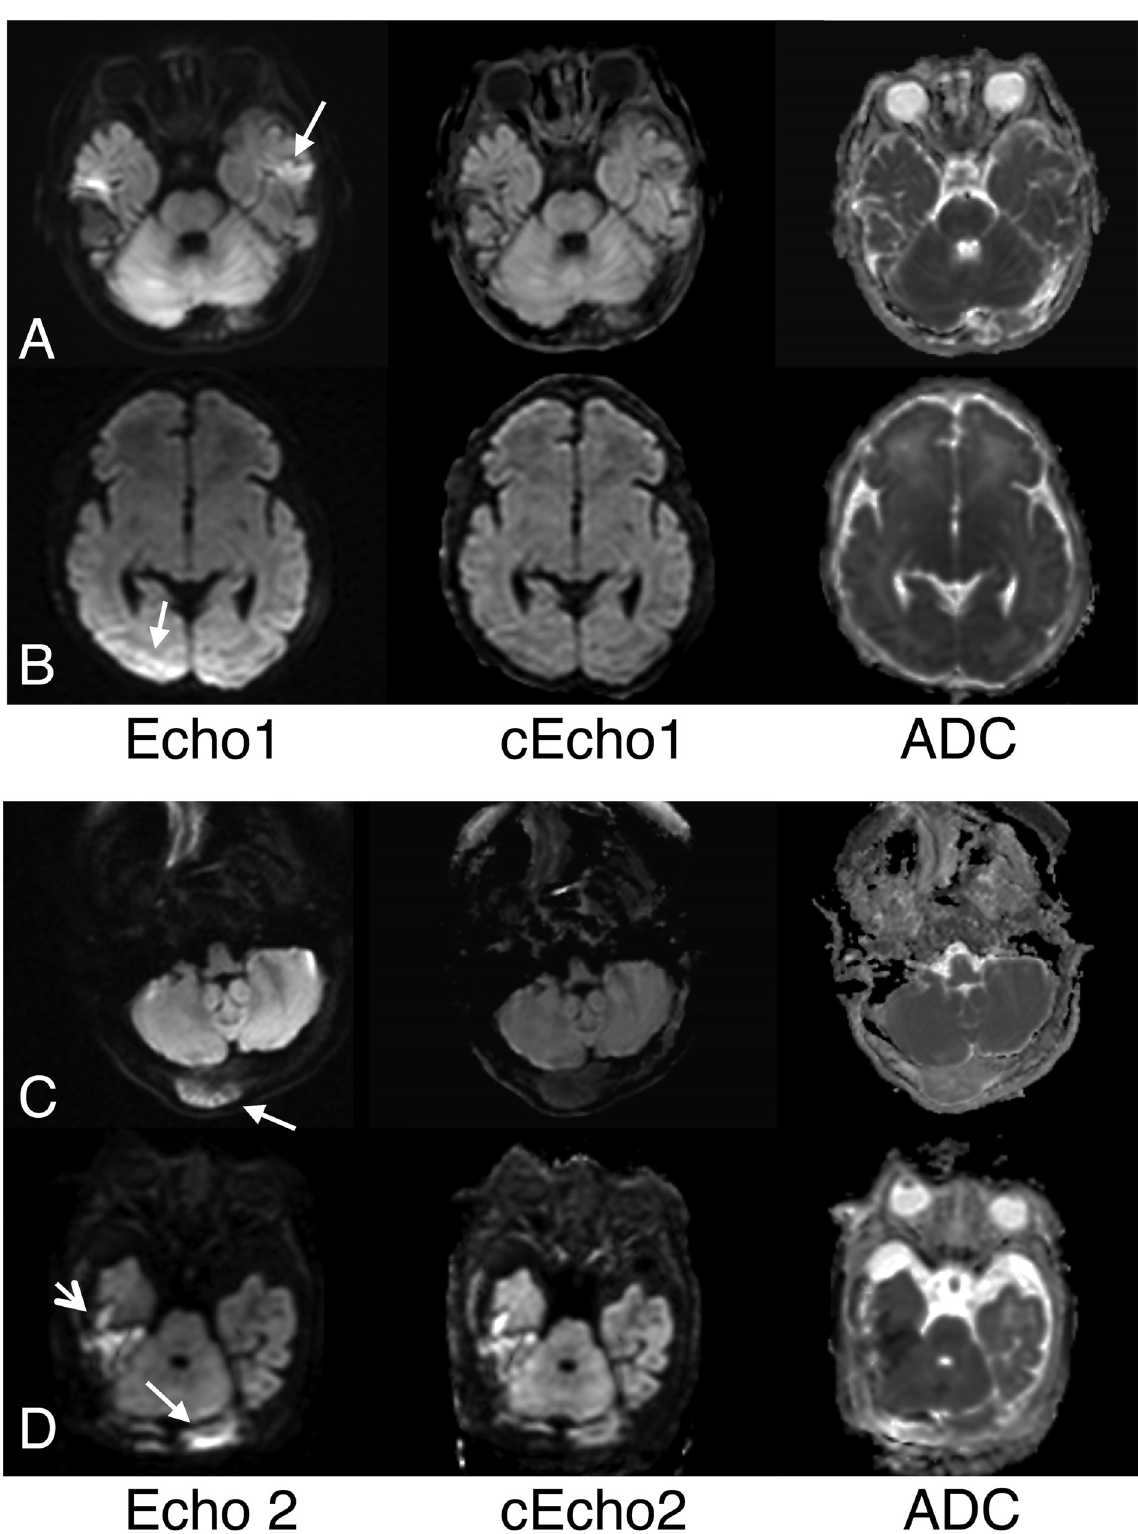
Fig 7. Examples of false positives lesions. The majority of these cases resulted from coil-induced brain signal variations in the posterior regions and/or susceptibility-related high signal present in baseline echoes (Echo1 and Echo2). A. Left temporal lobe cortical high signal (arrow) seen on multiple axial